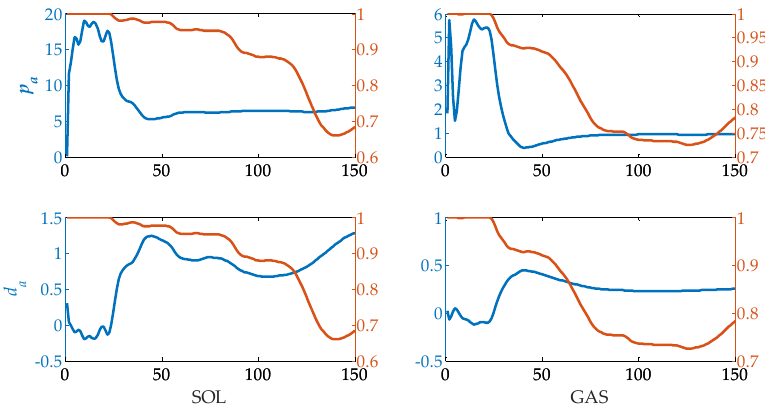
Figure 9. Variations of p a and d a of a single trial. The blue lines are the p a and d a values. The red lines are the VAF values of prediction results.